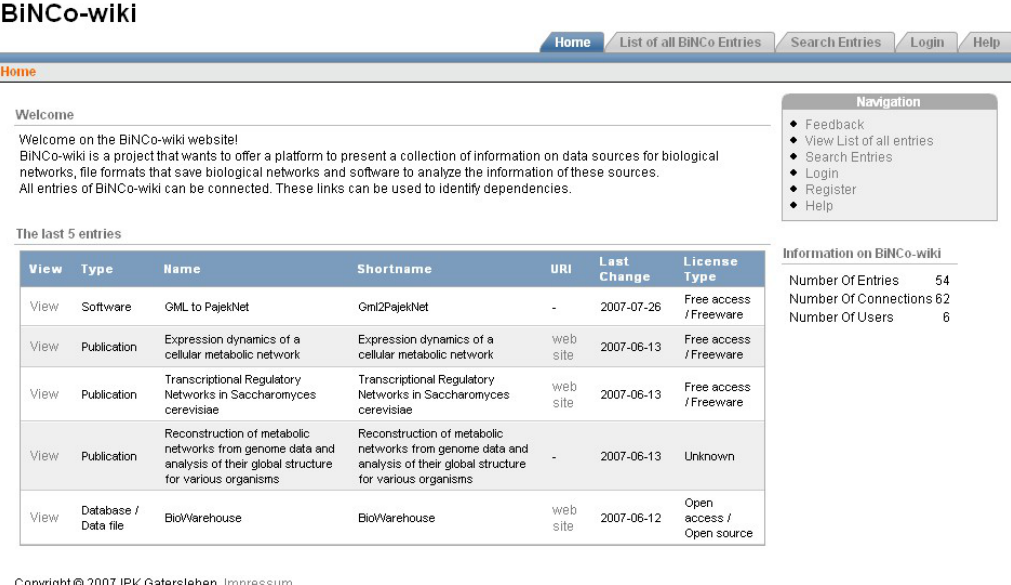
Figure 1: Screen shot of the BiNCo-wiki home page. On this page a welcome message, the five newest entries, and statistical information are displayed. The tab bar (top right) is visible on every